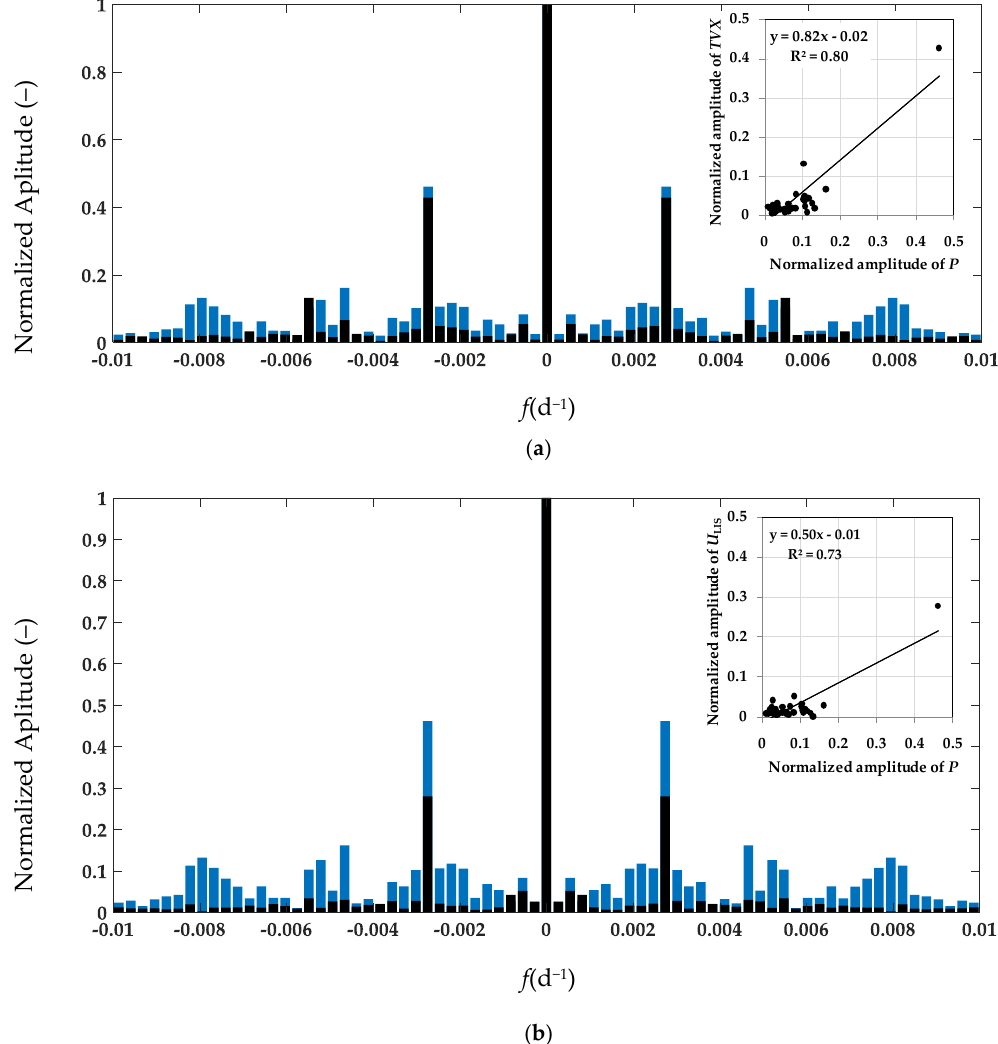
Figure 14. Normalized FFT spectra in the frequency domain ± 10 − 2 d − 1 : ( a ) P (blue bars) vs. TVX (black bars); ( b ) P (blue bars) vs. U LIS (black bars). Days in x-axes start from 1st of January 2001. Total daily rainfall was measured at Drasi gauge station.